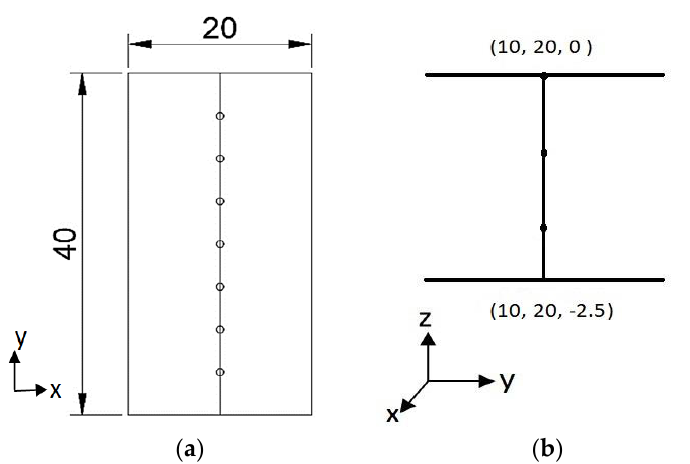
Figure 8. Boundary temperature probe points ( a ) along weld line (y axis) and ( b ) along the thickness (z axis).